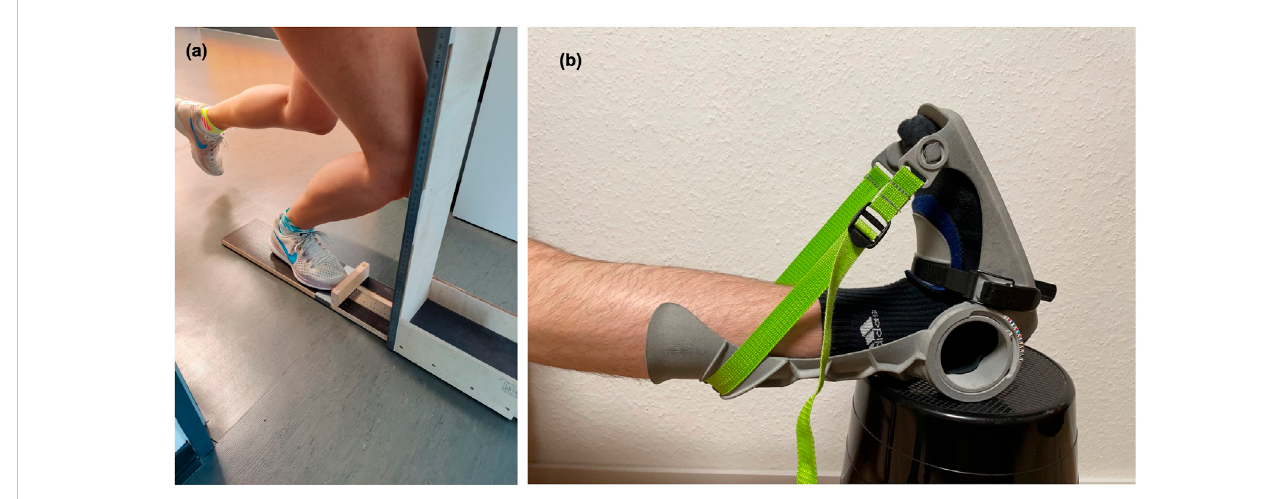
FIGURE 3 Measurement of fl exibility via KtW (A) and ORTH (B) .